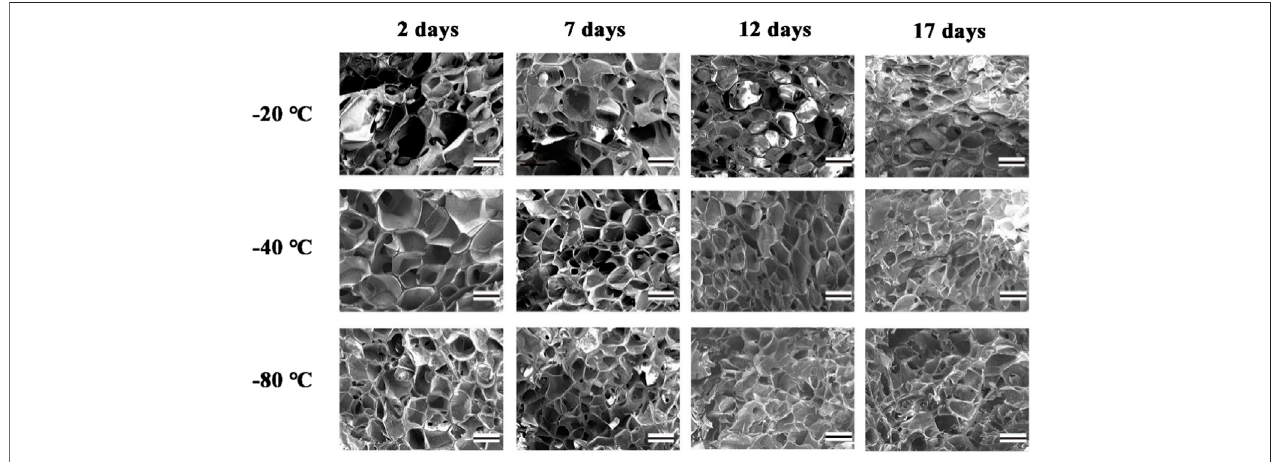
FIGURE 3 | The SEM of GelMA Hydrogels with different freezing temperatures and time. (Scale bars represent 200 µm in all images).